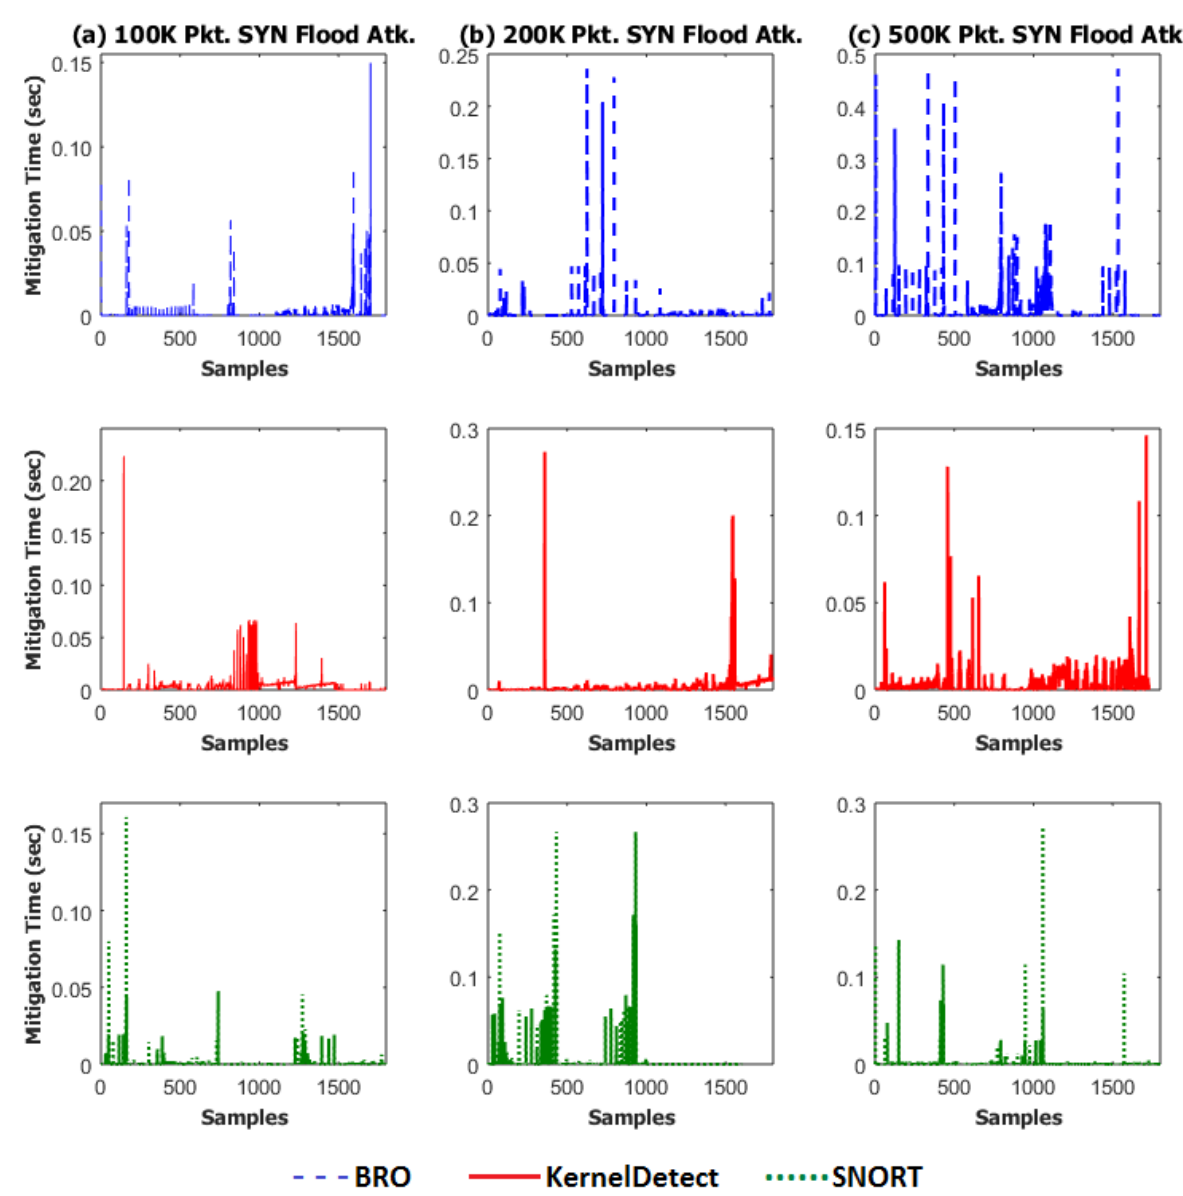
Figure 9. Threat mitigation time for each IDS under 100K, 200K and 500K SYN flagged packet DoS attack using a 15 second